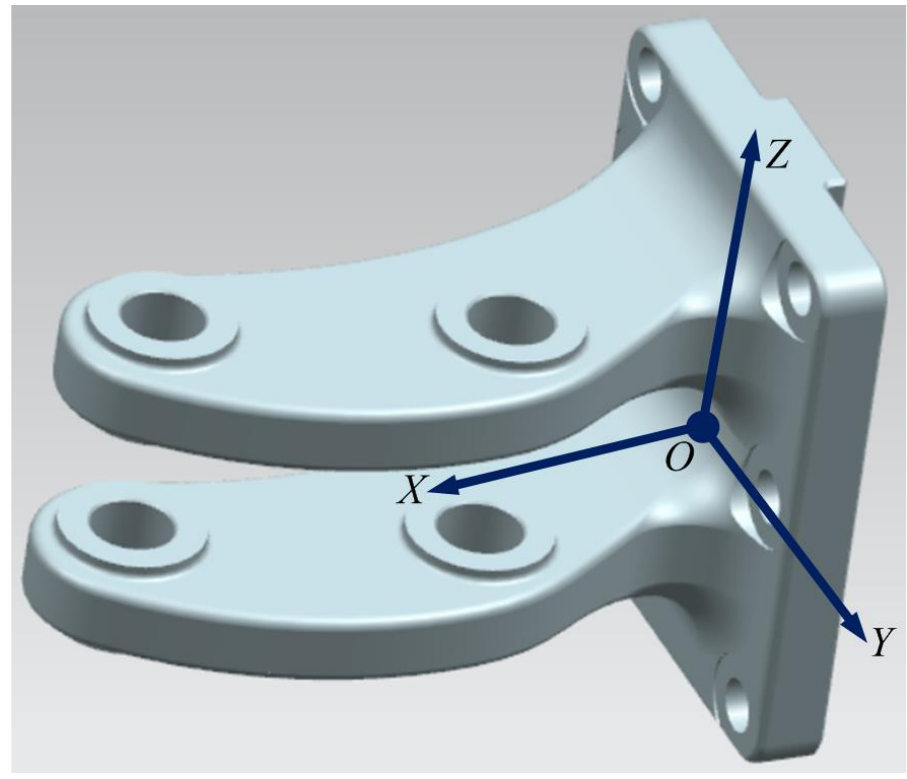
Figure 17. Improvement scheme 1.